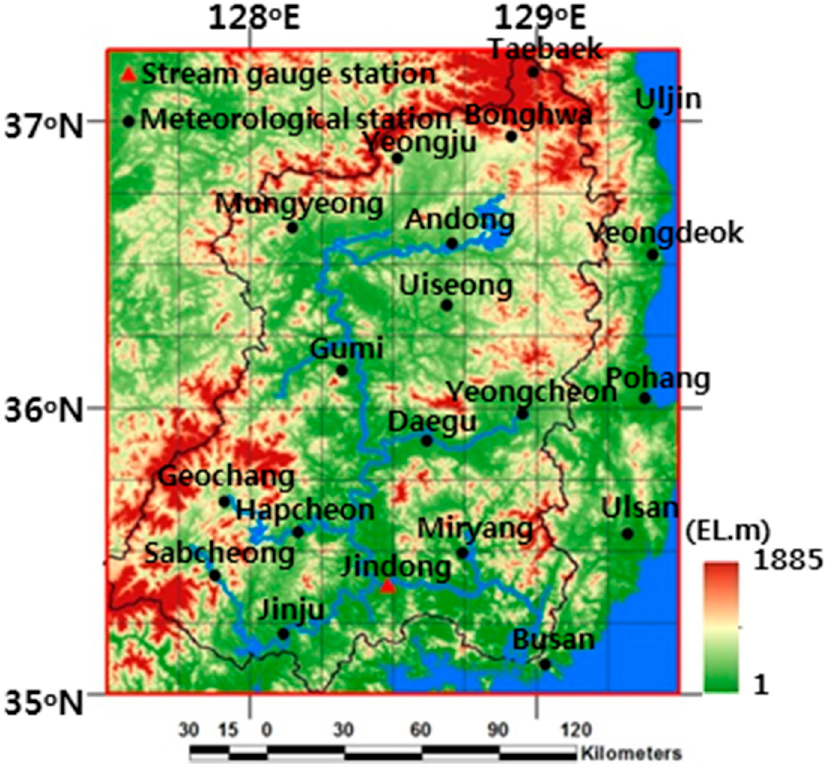
Figure 1. Location map for meteorological and stream gauge stations in the study watershed overlaid with the main streamline and the watershed boundary of the Nakdong River in Korea on the 30-km computational grid mesh.